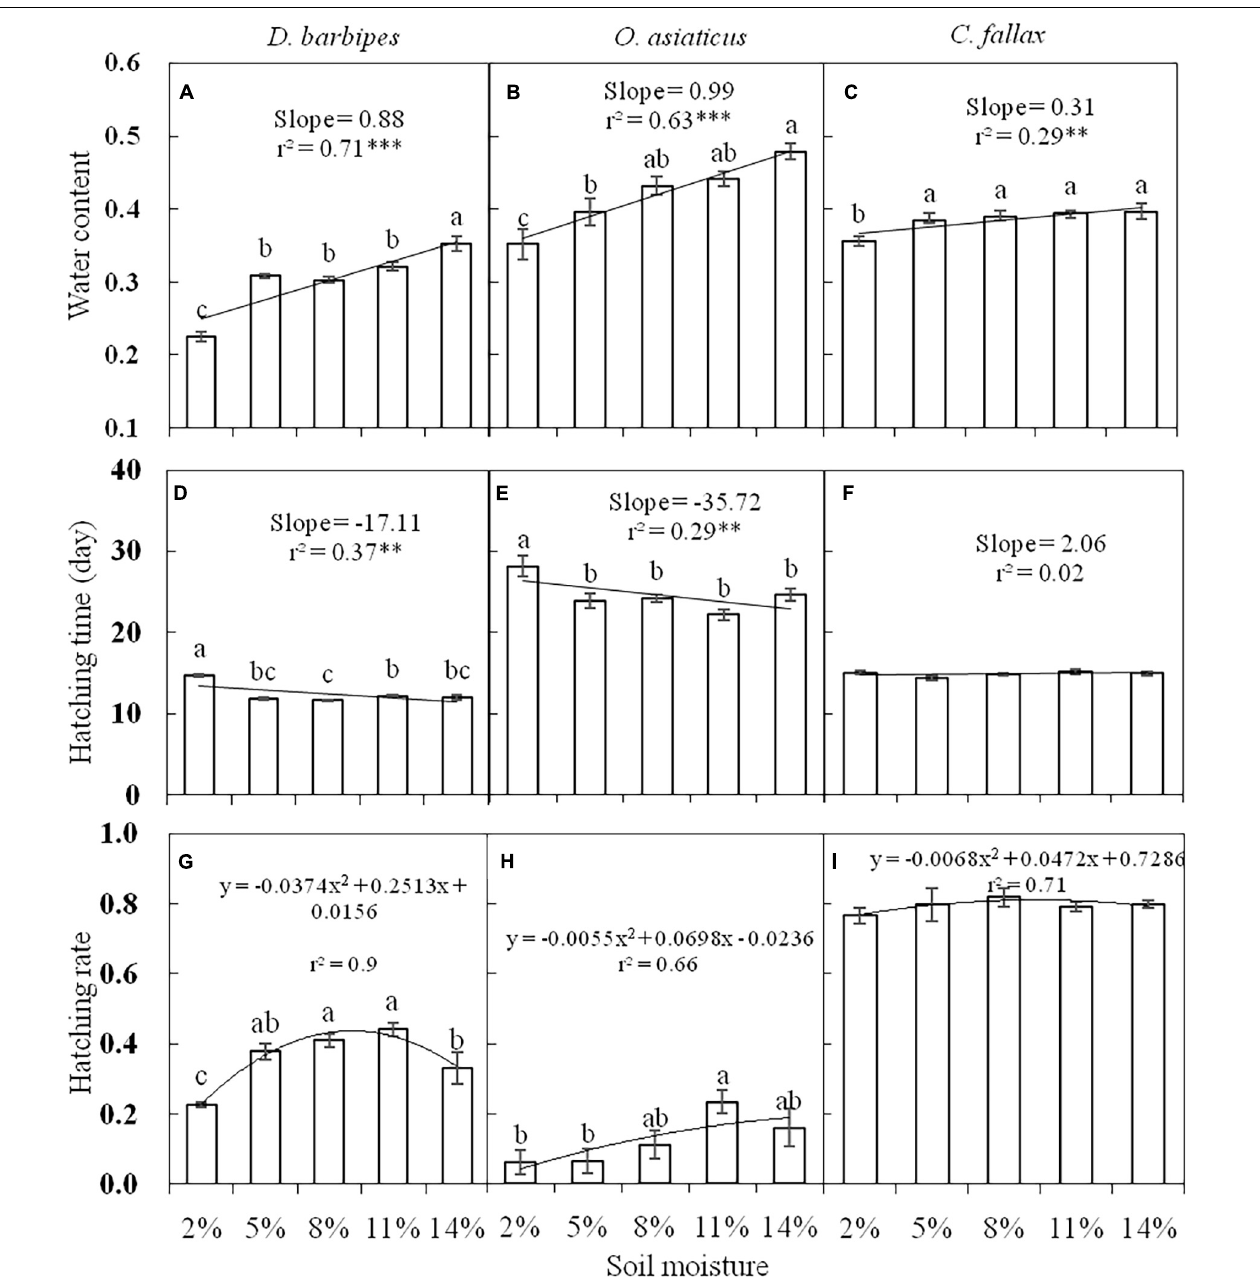
FIGURE 1 | The water content (A,B,C) , hatching time (D,E,F) , and hatching rate (G,H,I) of eggs of D. barbipes, O. asiaticus and C. fallax in different soil moisture treatments. Regression parameters were estimated using linear models with soil moisture as a continuous predictor. Significant regressions are indicated by ∗ ( P < 0.05), ∗∗ ( P < 0.01), and ∗∗∗ ( P < 0.001). Lowercase letters above bars indicate within-species differences based on Tukey HSD post hoc analyses following ANOVA. Data are mean ± SE ( n = 6).